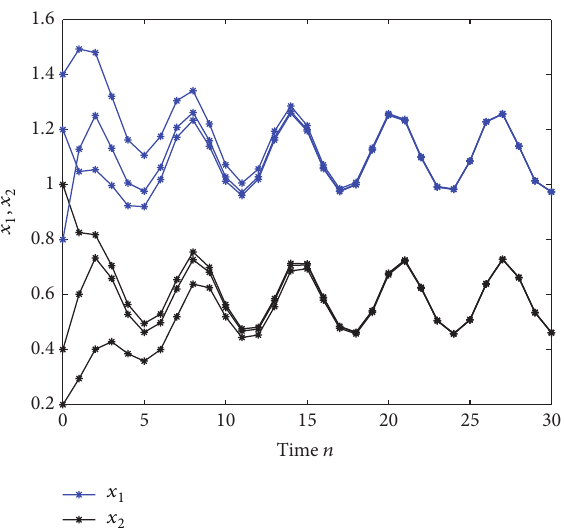
Figure 2: Numeric simulations of the solutions (𝑥 1 (𝑛),𝑥 2 (𝑛), 𝑢(𝑛)) of system (106), with the initial conditions (𝑥 1 (𝑠),𝑥 2 (𝑠),𝑢(𝑠)) = (0.8, 1.4, 1.2) , (0.5, 1.2, 1.5) , and (0.2,1.6, 2.1) , 𝑠 = ⋅⋅ ⋅ ,−𝑛, −𝑛 + 1, ...,−1,0 , respectively.